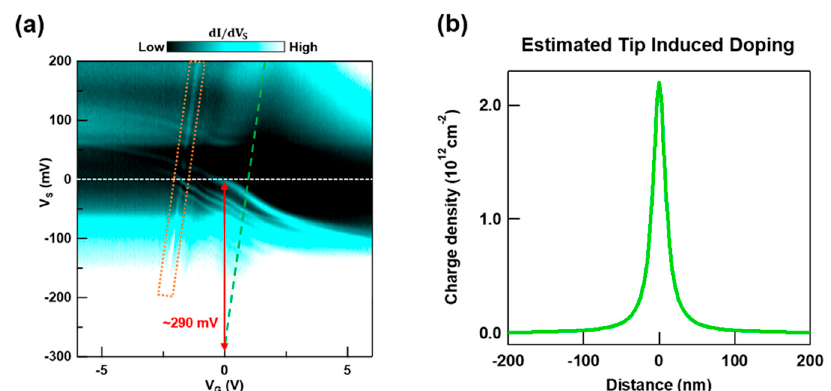
Figure 4. Determination of the charge density profile induced by the STM tip on graphene. ( a ) Experimentally determined dI / dV S ( V G , V S ) on pristine graphene. This two-dimensional (2D) plot is used to determine the magnitude of the STM tip’s band shifting effect on graphene. The inverted “S” shaped features correspond to direct tunneling into tip-induced confined states. Diagonal features correspond to the charging of spectroscopic features as they coincide with E F . The dashed orange box encloses a charging feature due to a tip-induced state and the green dashed line outlines a dI / dV S suppression belonging to graphene’s charge neutrality point (CNP). The dashed white line indicates where V S = 0. Tunneling parameters: V S = − 0.2 V, I = 1 nA, V ac = 2 mV. ( b ) Charge density profile induced on graphene by the STM tip. The induced charge density intensity is extracted from the extrapolation in ( a ). The shape of this density profile is determined by assuming the tip to be a charged sphere with a radius of 80 nm.